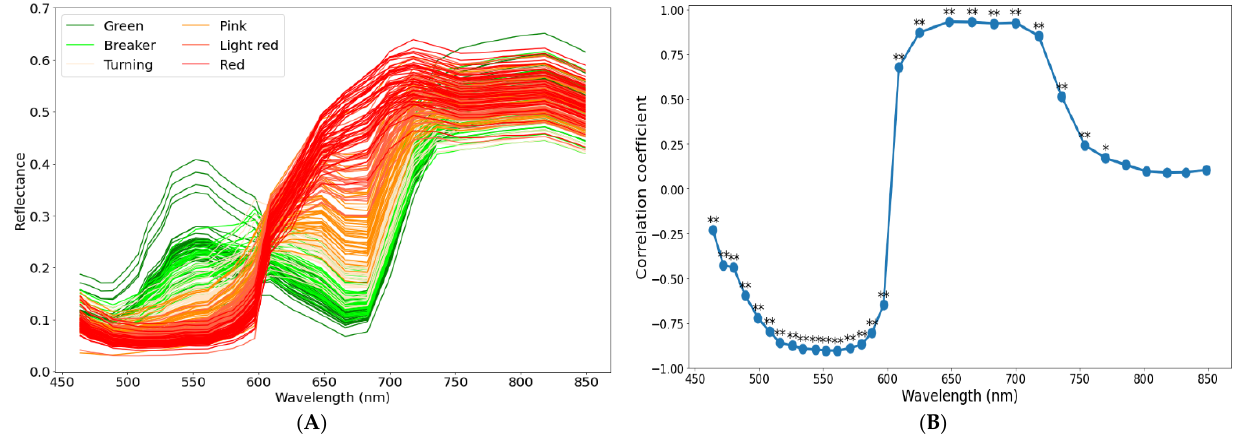
Figure 5. The spectral curves of six different maturity stages of the intact tomatoes ( A ) and the cor- relation coefficient between maturity stages and each waveband ( B ). ** and * Correlations are sig- nificant at the 0.01 and 0.05 levels, respectively.